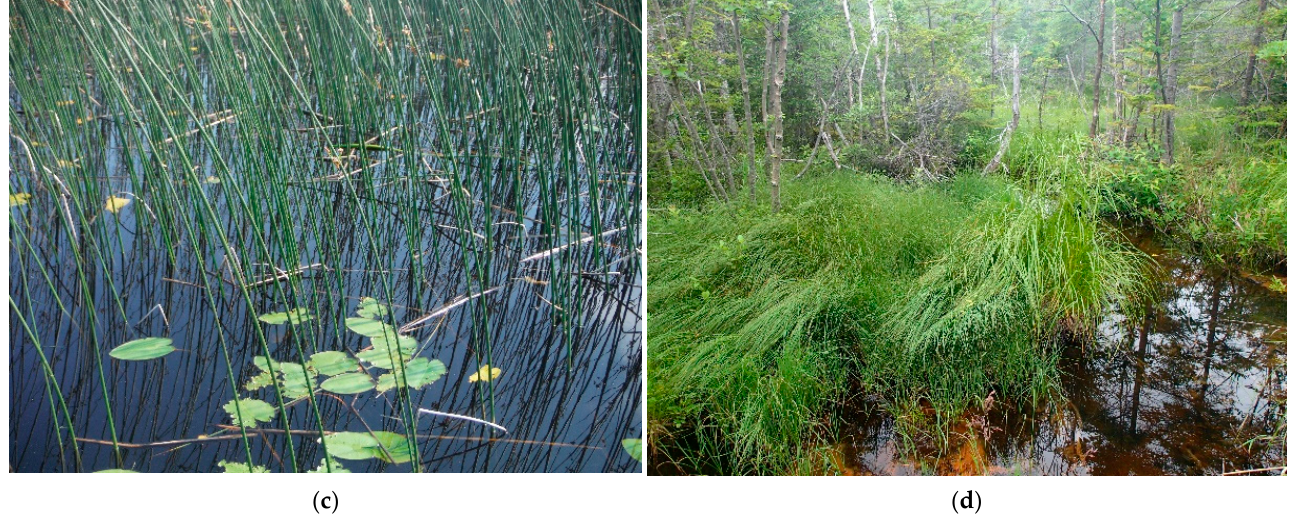
Figure 5. Ground reference photos showing wetland classes in the study area: ( a ) Bog; ( b ) fen; ( c ) marsh; and ( d ) swamp.